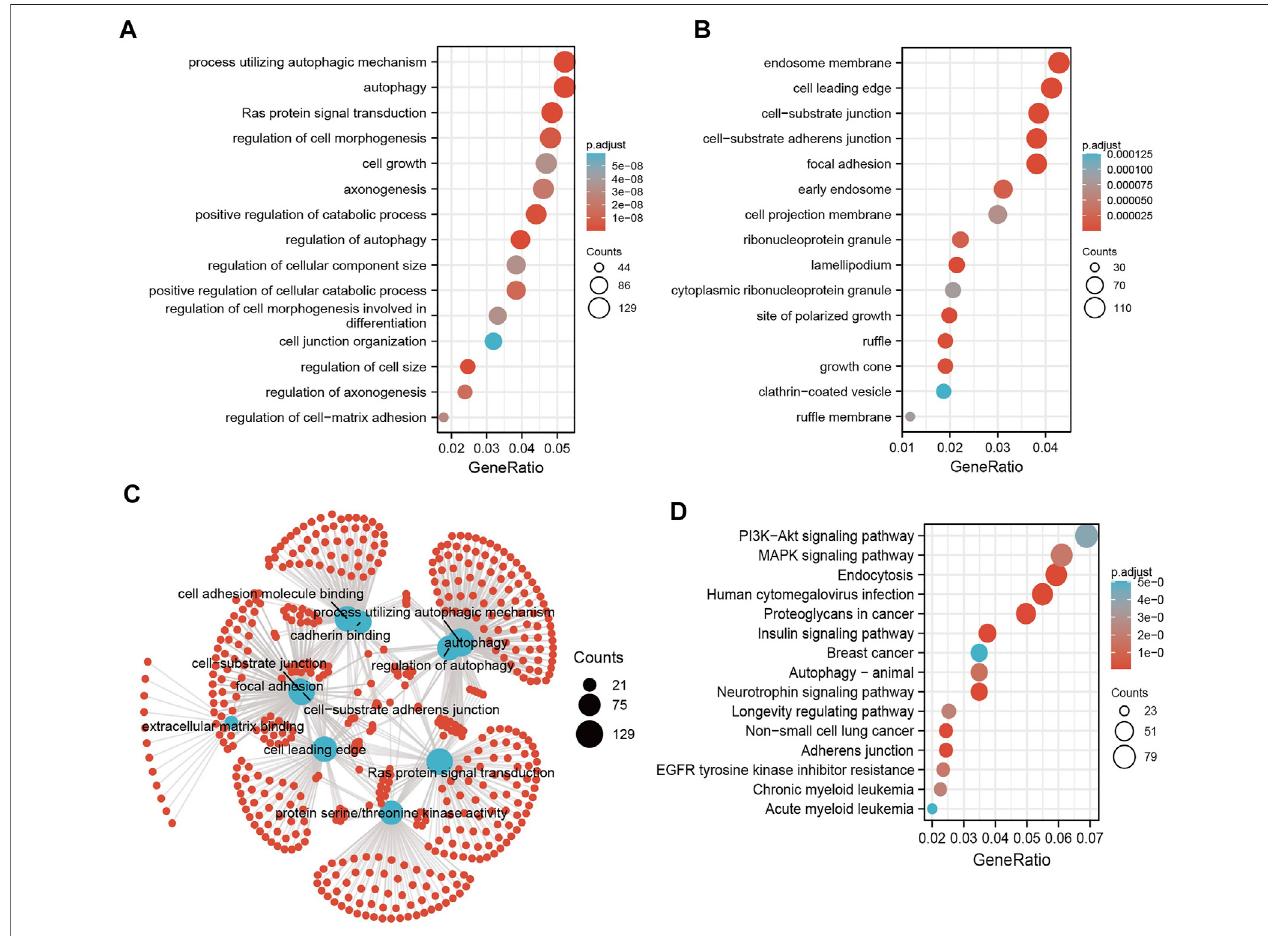
FIGURE 3 | Analysis of the functions of the downstream target genes of miR-125b-5p in human cancers. (A – C) Gene Ontology (GO) terms of the downstream target genes of miR-125b-5p in pan-cancer analysis. (D) Kyoto Encyclopedia of Genes and Genomes (KEGG) signaling pathways of the downstream target genes of miRNA-125b-5p in pan-cancer analysis by